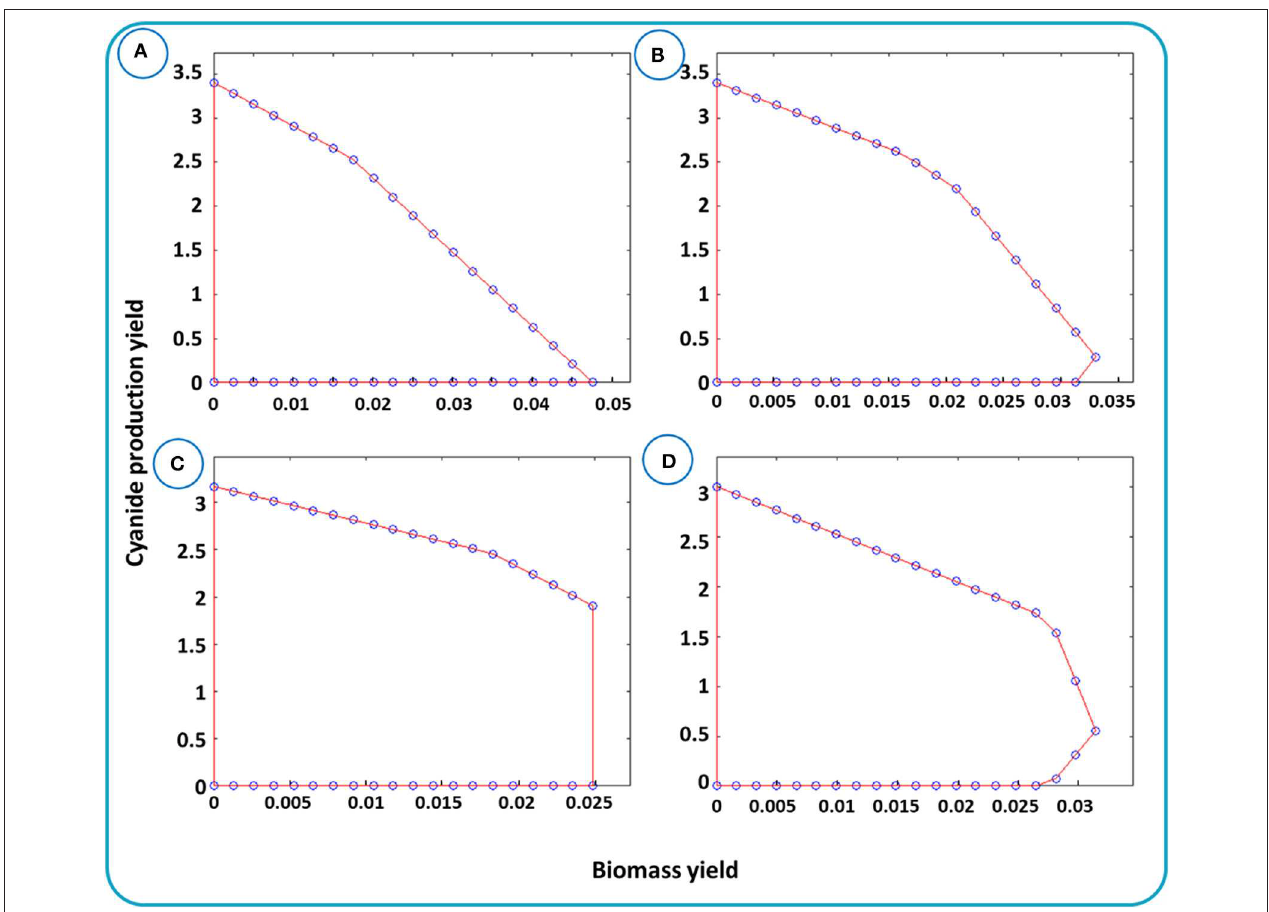
FIGURE 5 | Yield spaces for cyanide production in B. megaterium DSM319 evaluated for the metabolic network i JA1121. Yield space for cyanide and biomass with the given bounds is presented in (A) . Yield space for cyanide and biomass after omitting the reactions raised by cMCSs with µ min equals to (B) 0.1, (C) 0.3, and (D)